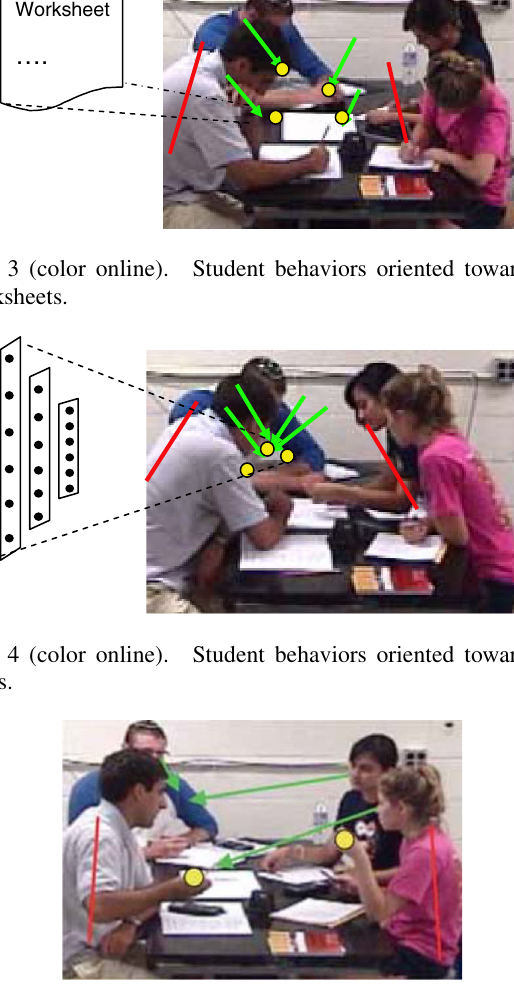
FIG. 5 (color online). Student behaviors oriented toward each other.